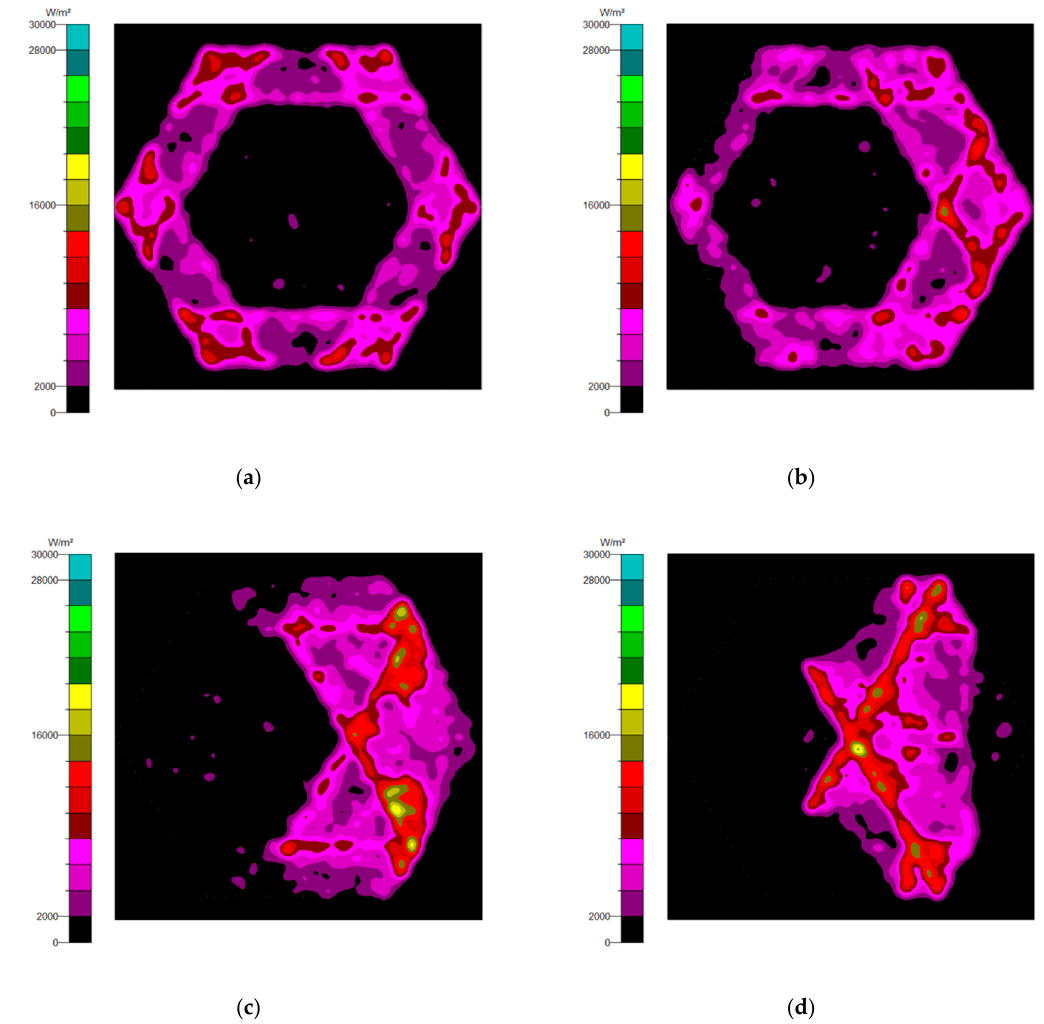
Figure 14. The irradiance distribution of the mirror-NACPC with misalignment angles of ( a ) 0°, ( b ) 10°, ( c ) 20°, and ( d ) 30°.